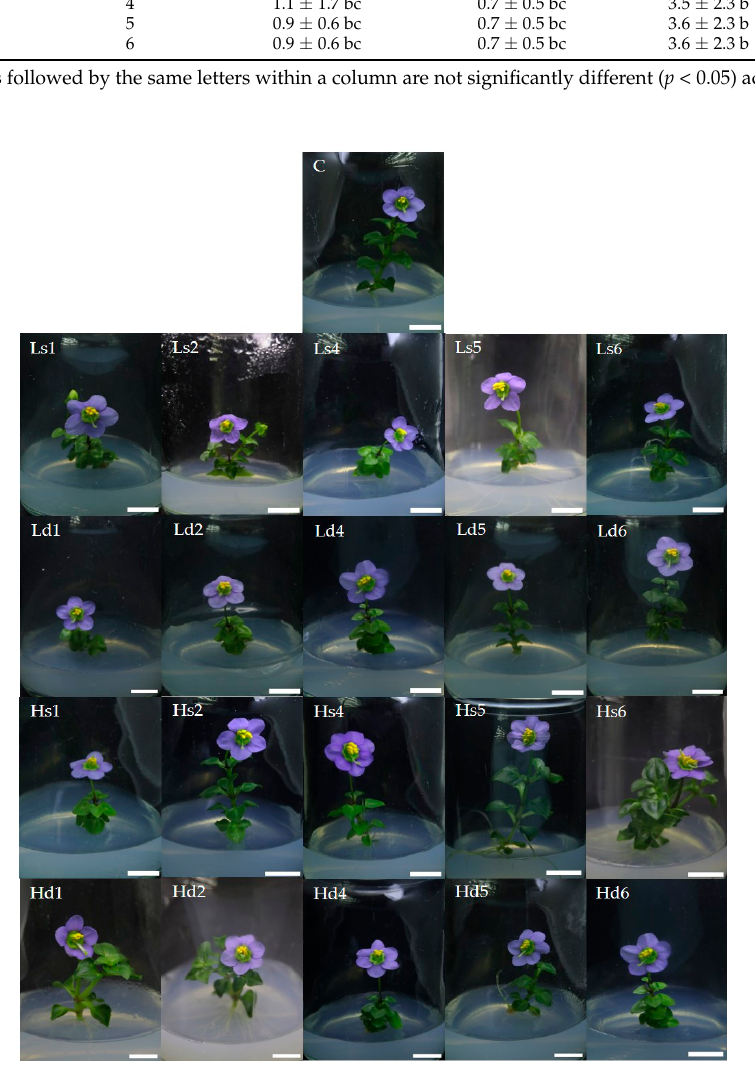
Figure 3. Effect of low ‐ and high ‐ intensity UV ‐ C on Persian violet shoot height in vitro after subsequent culturing for 8 weeks: C = control; L = low ‐ intensity; H = high ‐ intensity; s = single irradiation; d = double irradiation; 1, 2, 4, 5, and 6 = 1, 2, 4, 5, and 6 h, respectively (scale bar = 1 cm).